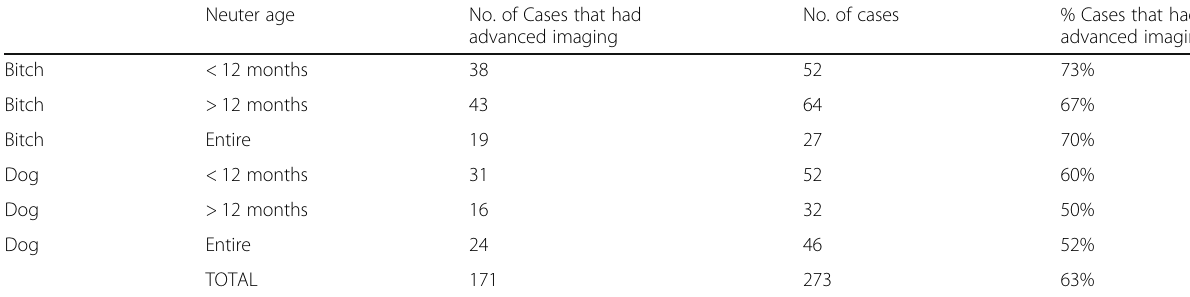
Table 4 Cases diagnosed with and without advanced imaging Neuter